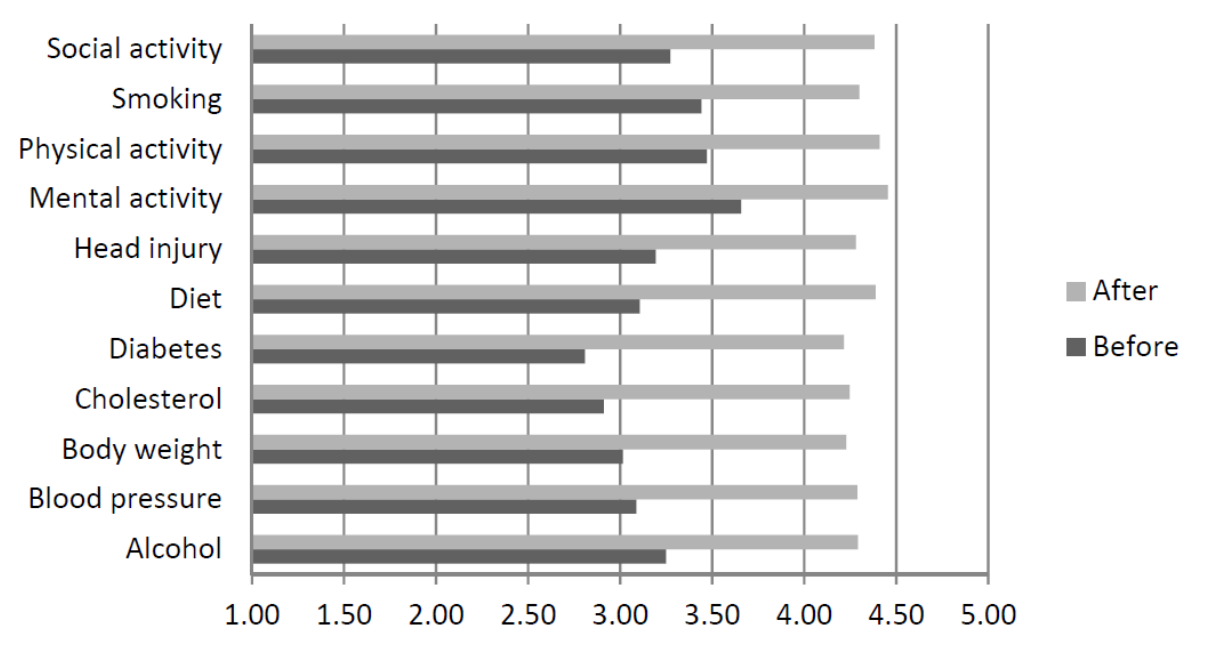
Figure 2. Mean ratings of knowledge about the link between risk or protective factors and dementia risk before and after visiting the Mind your Mind website (n=68). Ratings: 1=nothing at all; 2=not much; 3=a little; 4=quite a bit; 5=a